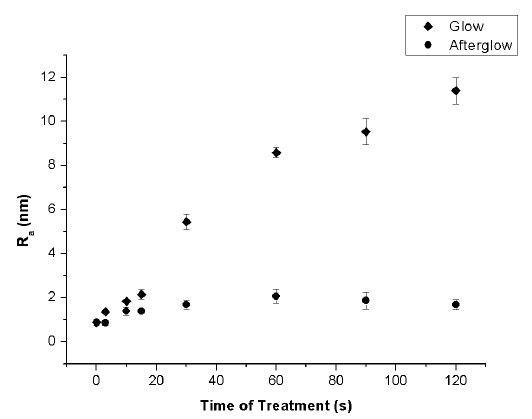
Figure 6 : Roughness evolution of samples upon exposure to oxygen plasma and its